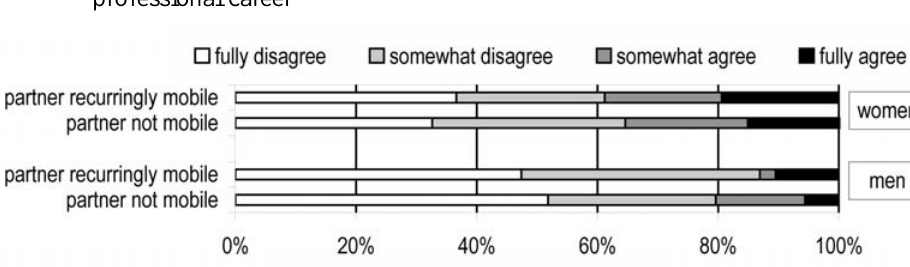
Figure 4 : Subjective evaluation of the consequences of childcare duties for one’s own professional